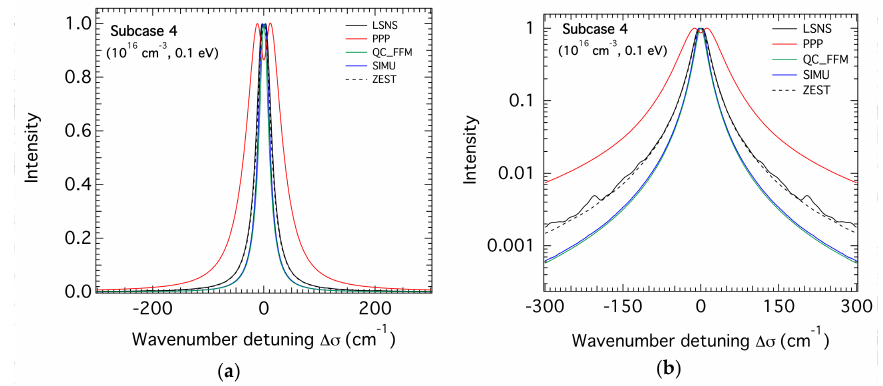
Figure 4. The theoretical Stark profiles of the H- β line calculated for hydrogen atoms in a helium plasma with an electron density of 10 16 cm − 3 and a temperature of 0.1 eV for both plasma He + ions and electrons. The profiles are centered at 486.1 nm and wavenumber units are used. ( a ) linear scale; ( b ) semi-logarithmic scale.